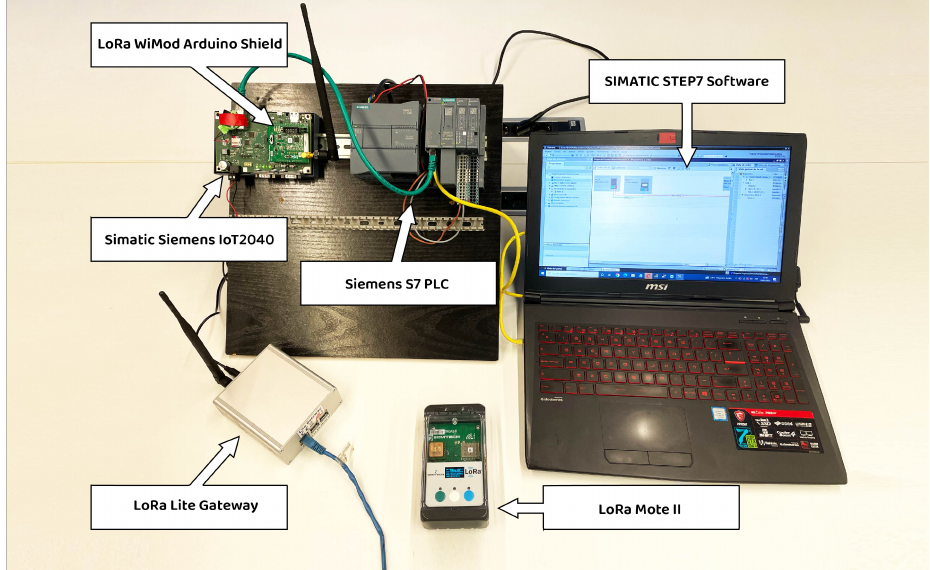
Figure 2. Siemens S7 PLC connected to Siemens Simatic IOT 2040 incorporating the Wimod LoRa shield. The LoRa gateway is powered and connected to the internet. The inputs/outputs of the different devices in the farm are simulated with the Simatic Step7 software and controlled with the S7 Siemens